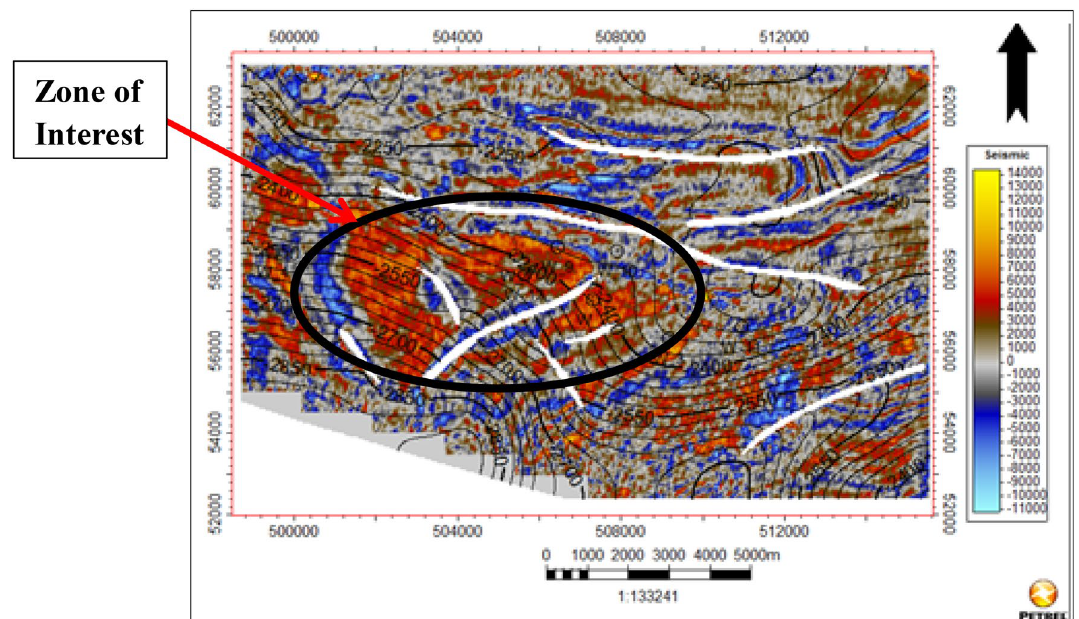
Fig. 11 Interval average arithmetic attribute extracted on horizon